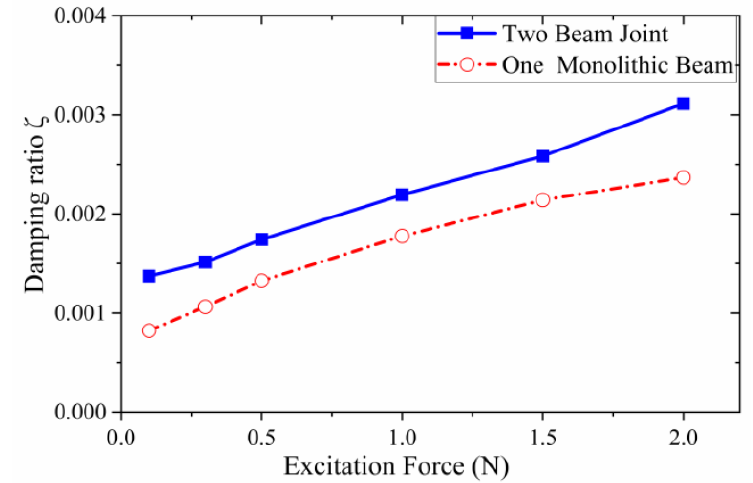
Figure 15. Modal damping ratios for different excitation force amplitudes (bolt tension = 5 kN).